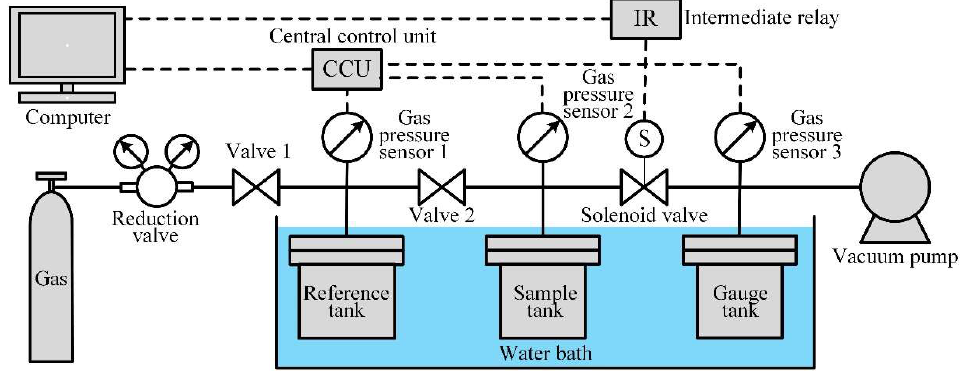
Figure 1. Meter for the gas release characteristics.